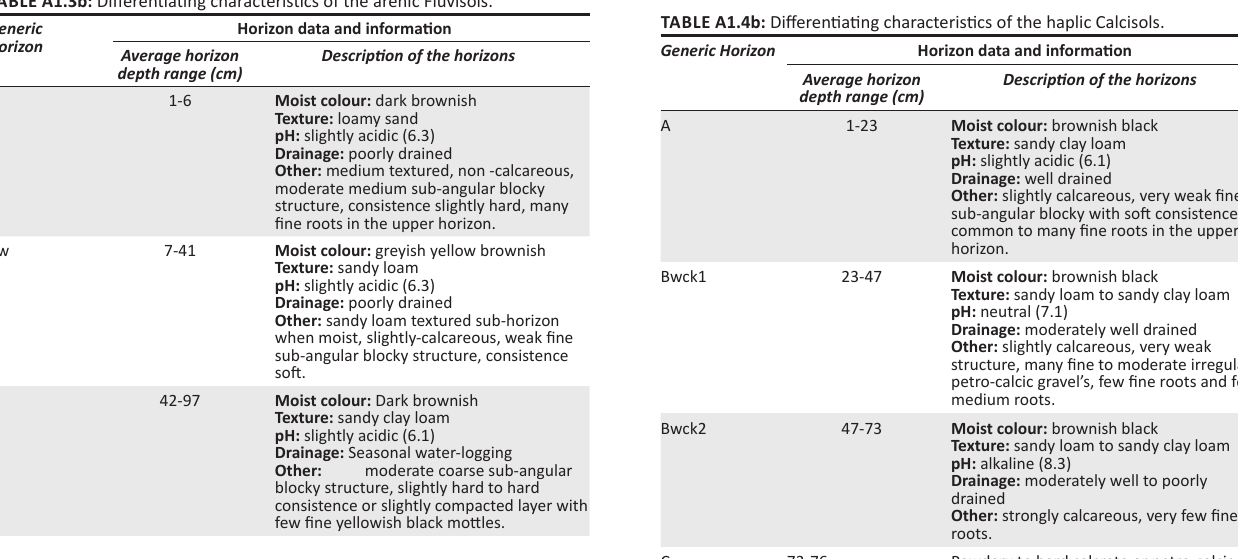
TABLE A1.3b: Differentiating characteristics of the arenic Fluvisols.